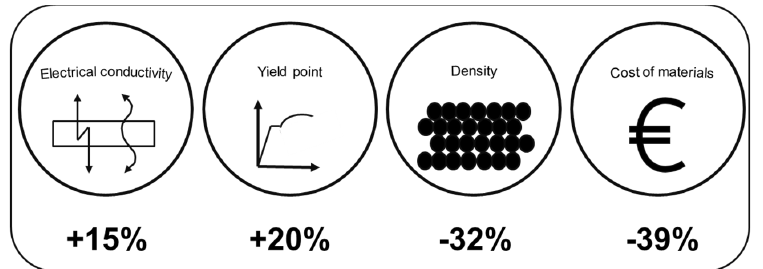
Figure 1. Advantages of extruded zinc alloy ZEP1510 compared to brass CuZn39Pb3.